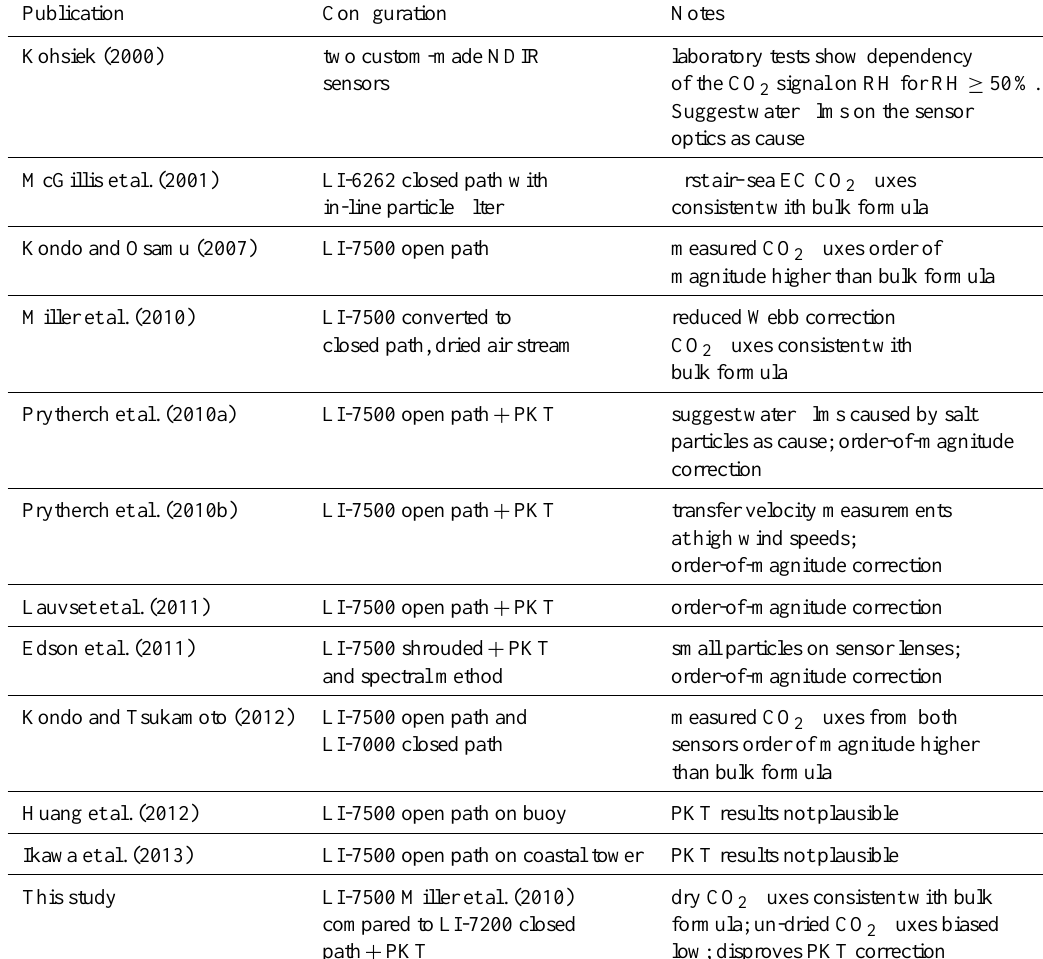
Table 1. Publications addressing the bias in NDIR CO 2 measurements that is related to relative